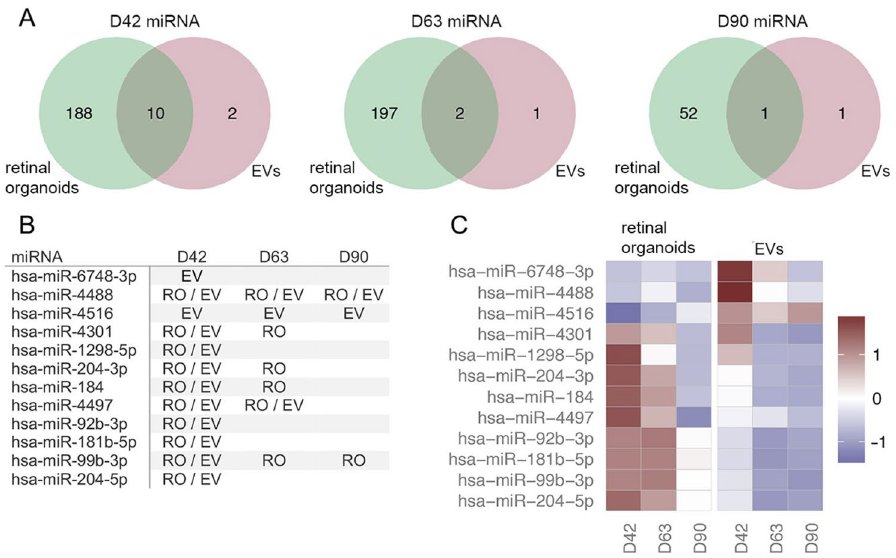
Figure 5. Next generation sequencing analysis of miRNA expression in hiPSC-derived 3D retinal organoids and EVs. ( A ) The Venn diagrams show the number of miRNAs expressed > 5 RPM in 3D retinal organoids, EVs, or both samples. D42, D63, and D90 represent the time (in days) when the samples were collected. ( B ) miRNAs expressed > 5 RPM in EVs (EV), retinal organoids (RO), or both (RO/EV) at each time point. miRNAs without annotation were either detected below the threshold or detected also in controls. The highest number of miRNA species in EVs was detected at D42 (n = 12) with fewer of those species present in both retinal organoids and EVs at D63 and D90. ( C ) Heatmap of miRNAs level in 3D retinal organoids and released EVs; miRNAs expressed > 5 RPM in EVs at any time point are shown. miR-6748-3p, miR-4488 and miR-4516 were enriched in EVs at D42 while miR-4516 was enriched above retinal organoids at all time points. The RPM values were log- transformed and standardized across samples for visualization. For each miRNA species, red-colored samples represent higher expression values than do blue colored samples. The color bar shows the range of standardized expression